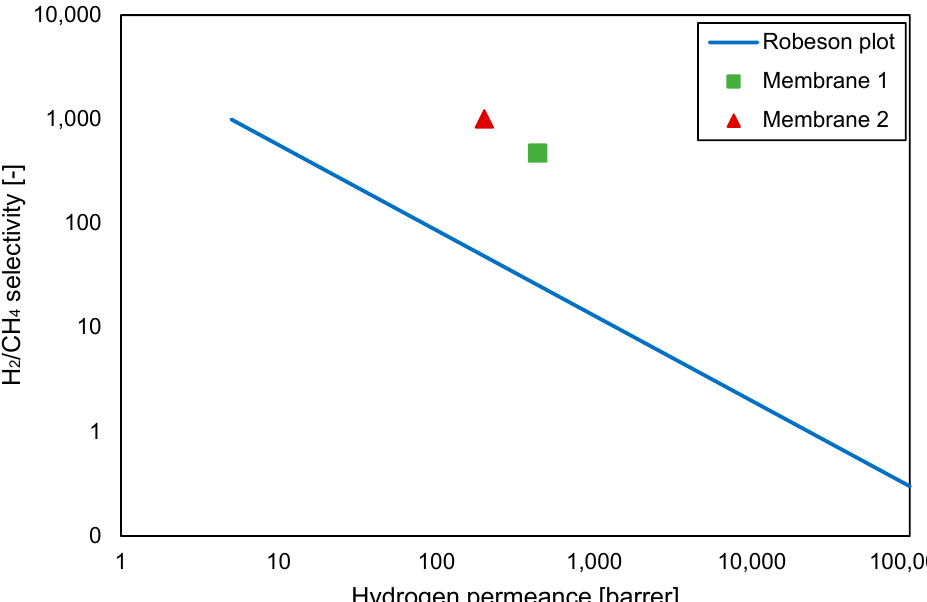
Figure 4. Comparison between Robeson upper bound and membrane permeability and selectivity for the CMSM-550 and CMSM-600 exposed to water from the atmosphere at a working temperature of 70 °C.